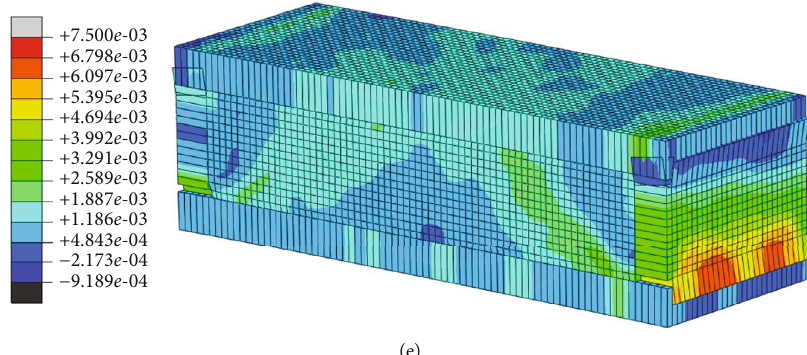
Figure 27: Strain clouds of the battery box at di ff erent bird speeds at impact point B. (a) 60mph, (b) 70 mph, (c) 80mph, (d) 90 mph, and (e) 100mph.